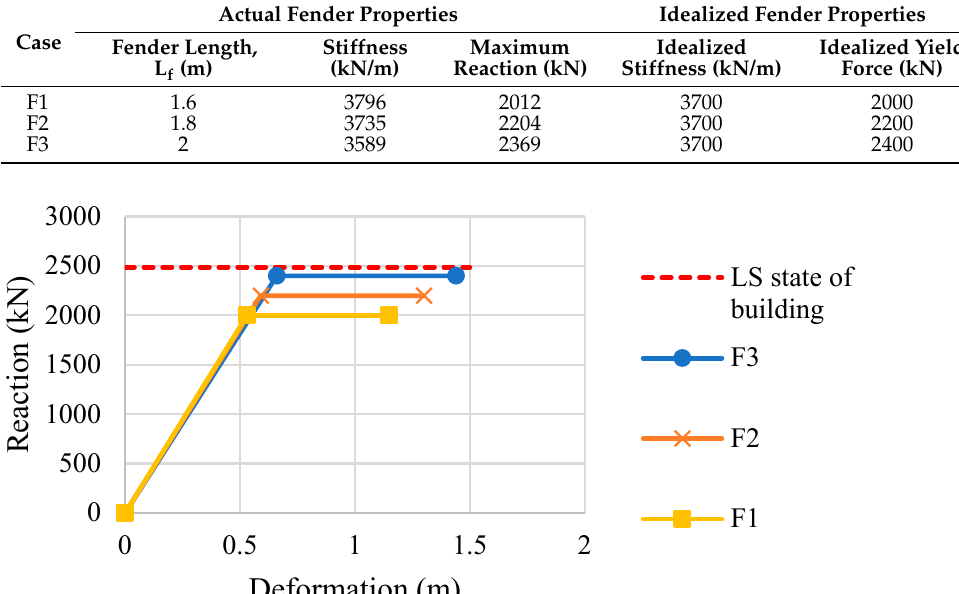
Table 4. Parameters of the fenders.